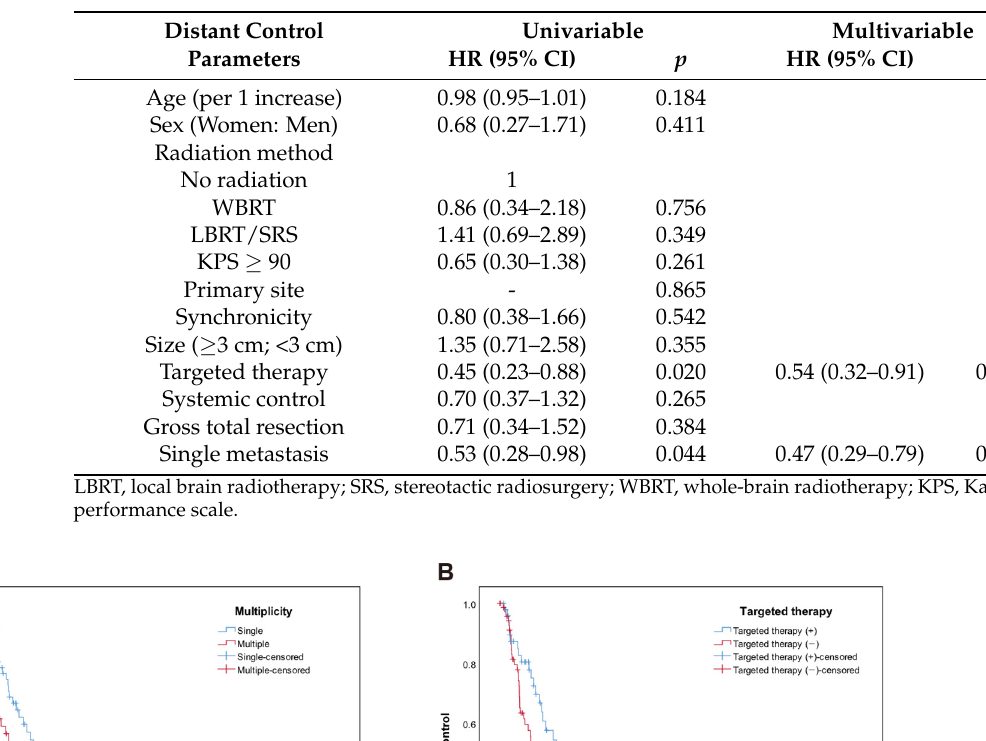
Table 4. Univariable and multivariable Cox regression for distant control.